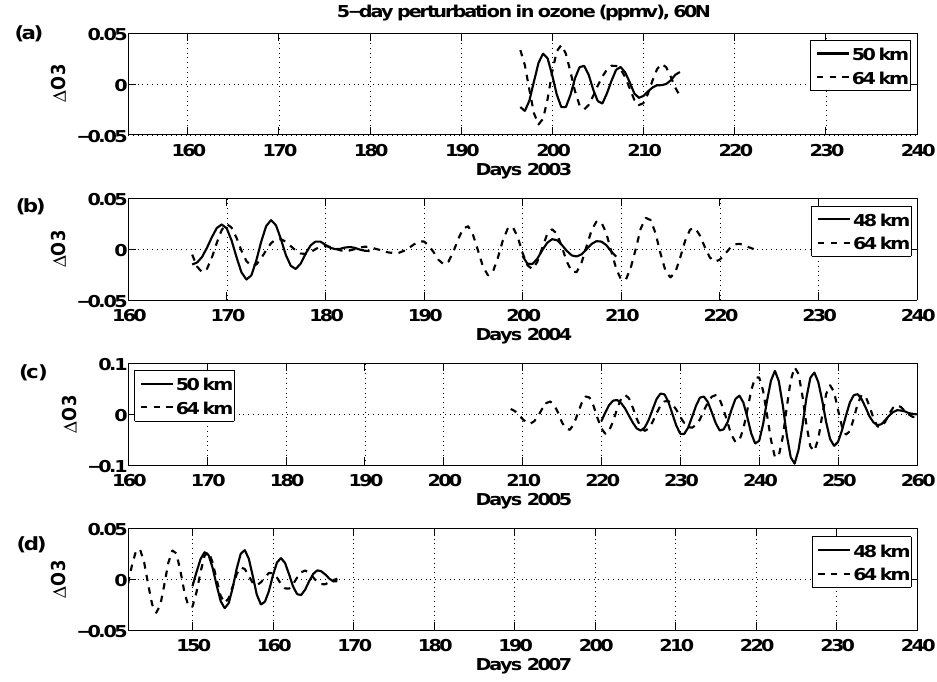
Fig. 3. 5-day ozone perturbations from Odin at 60 ◦ N for the NH summers of 2003, 2004, 2005 and 2007.